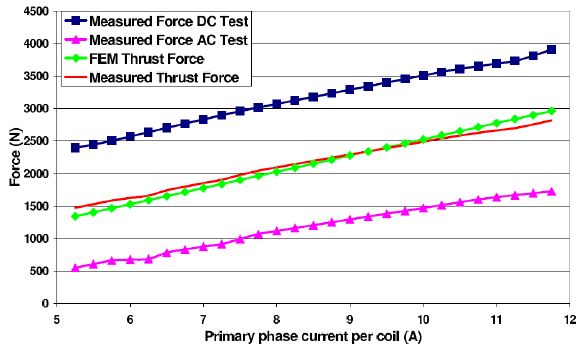
Figure 6. Measured and predicted forces for the buried magnet arrangement (van Zyl